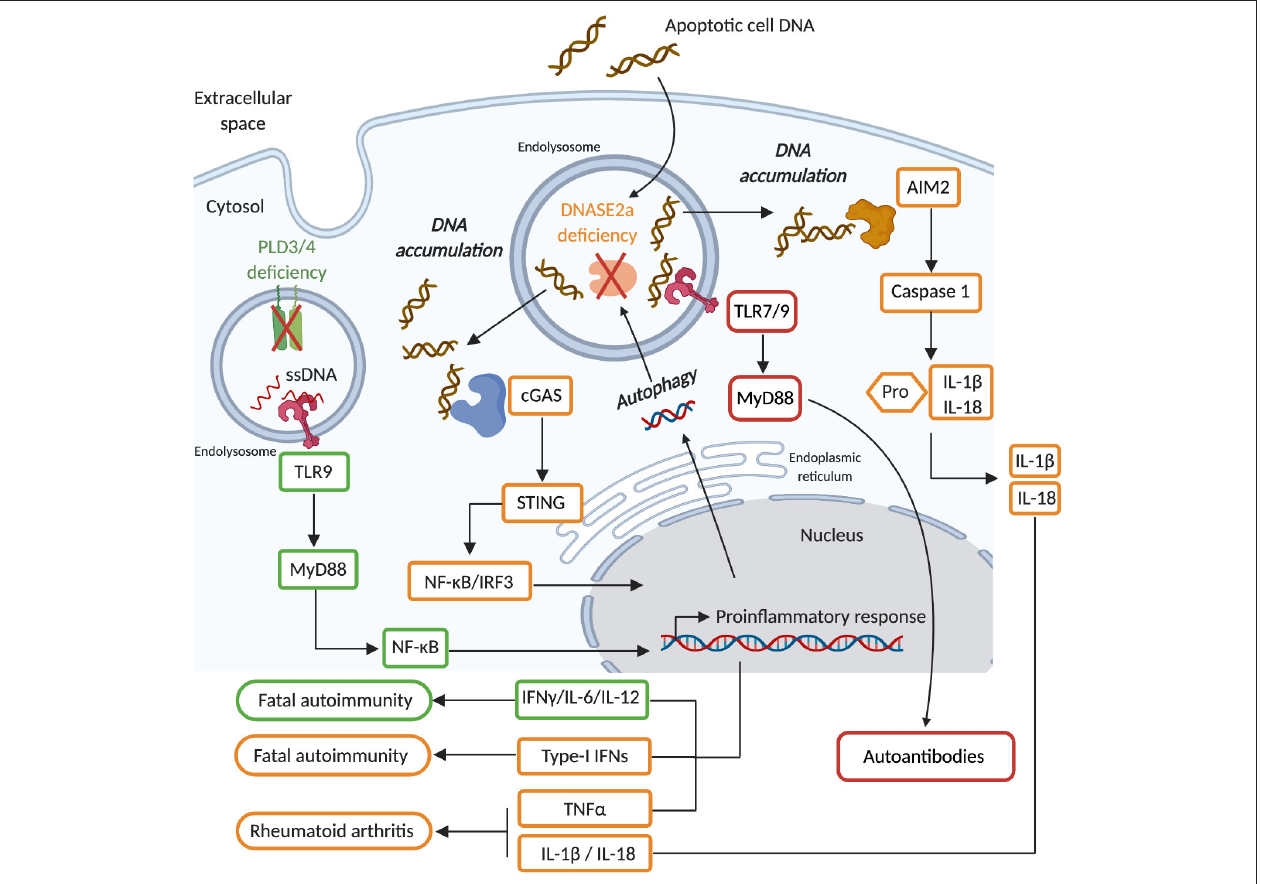
FIGURE 3 | DNASE2A deficiency causes an accumulation of phagocytosed dsDNA as well as nuclear dsDNA transported by autophagy into endolysosomal compartments. Such dsDNA can gain access to the cytosol and activate the cGAS/STING pathway (orange) that leads to the production of type I interferons (IFN-I), which ultimately causes the development of fatal autoimmunity. In the absence of IFN-I signaling DNASE2A deficiency will induce the development of rheumatoid arthritis which is mediated by TNF α , whose production is triggered by the cGAS/STING pathway, but also by IL-1 β and IL-18 which are inflammatory cytokines produced upon the activation of the AIM2 inflammasome by cytosolic self-DNA. Finally, DNASE2A deficiency also induces aberrant activation of endolysosomal TLR (red) which contribute via the activation of the MyD88 to the production of autoantibodies. PLD3/4 are novel endolysosomal nucleases (green) involved in the degradation of ssDNA. Their deficiency induces an accumulation of ssDNA in endolysosomes that ultimately activates TLR9-MyD88-NF κ B mediated inflammatory cytokine (IL-6 and IL-12) production, causing fatal